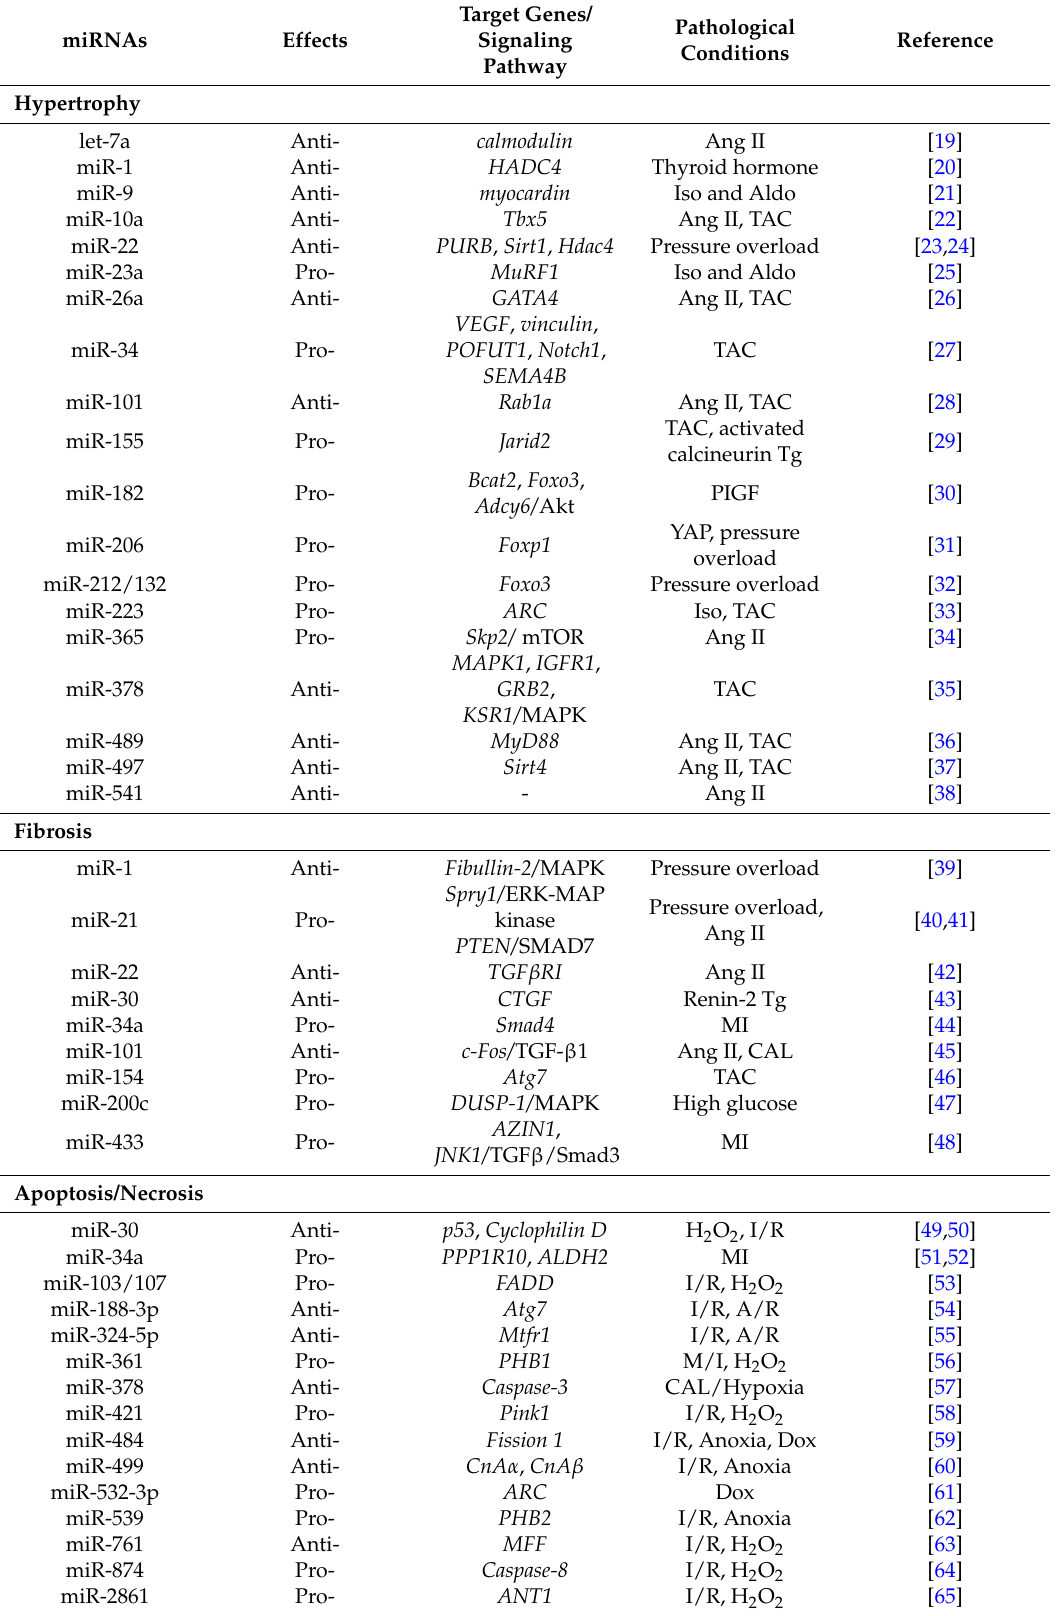
Table 2. Effects of miRNAs in pathological cardiac